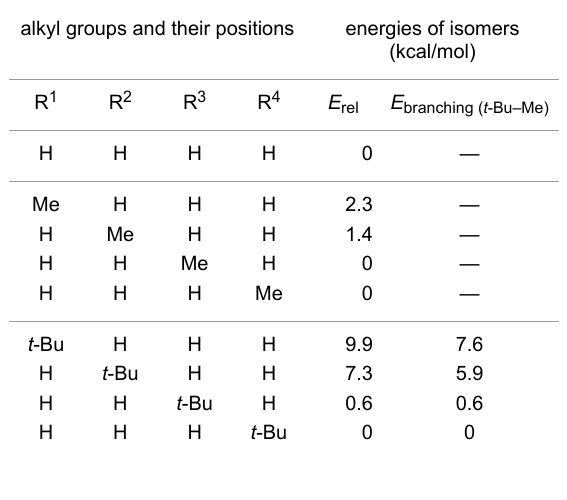
Table 5: Energy increase in 9 upon substitution at the α position